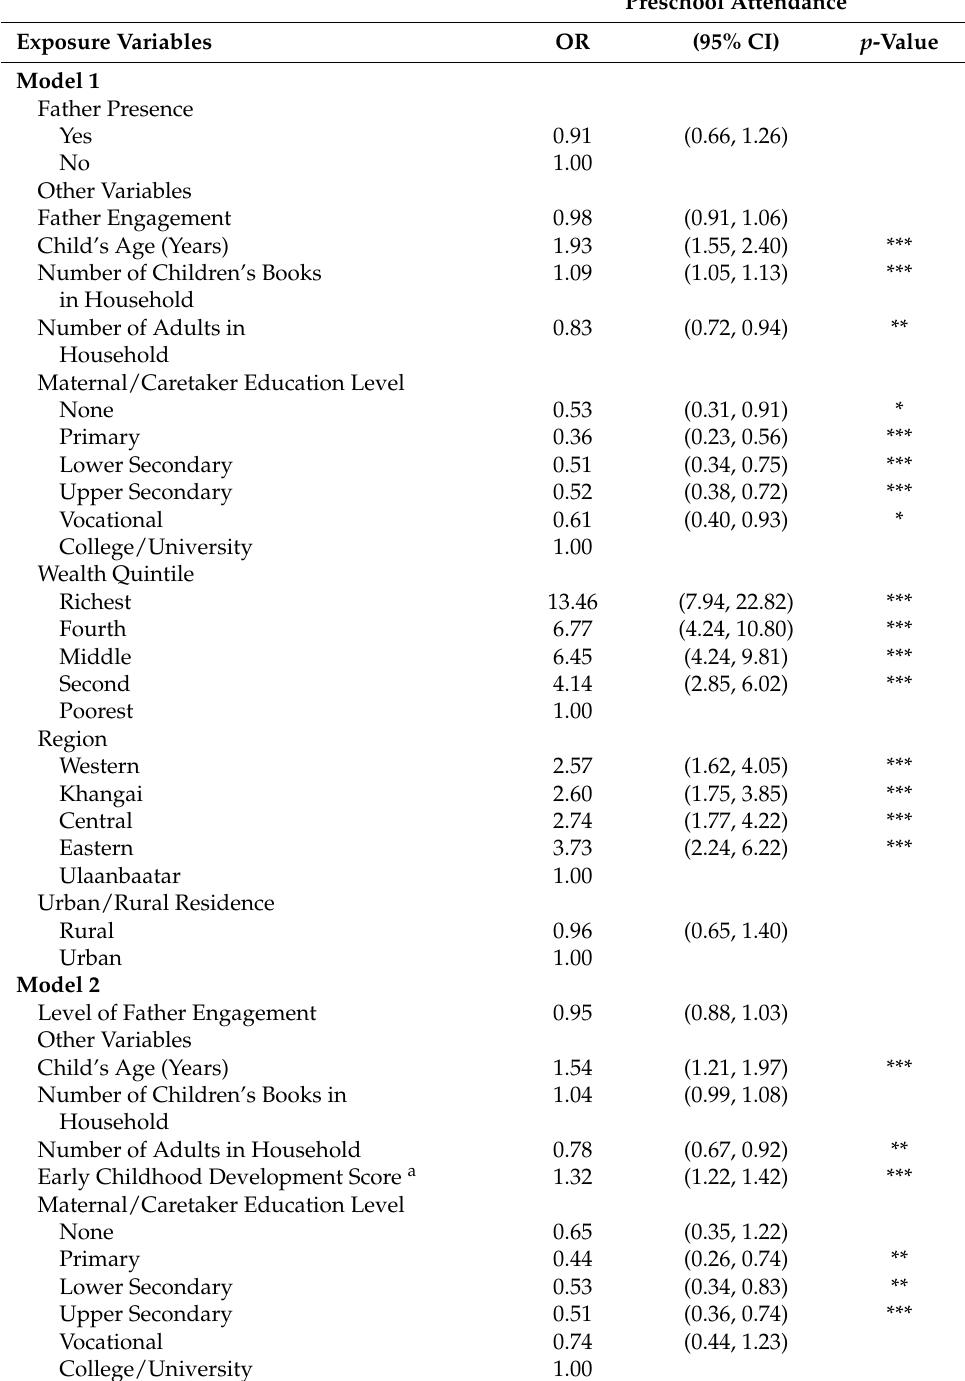
Table 3. Odds ratio estimates from multivariate regression models to measure the association between father presence and preschool attendance (Model 1) as well as level of father engagement and preschool attendance (Model